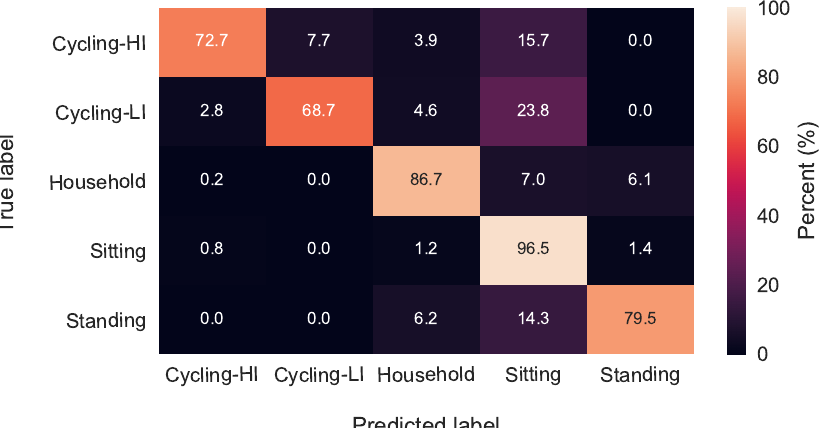
Figure 3. Confusion matrix of classification with both HR and ACC features.